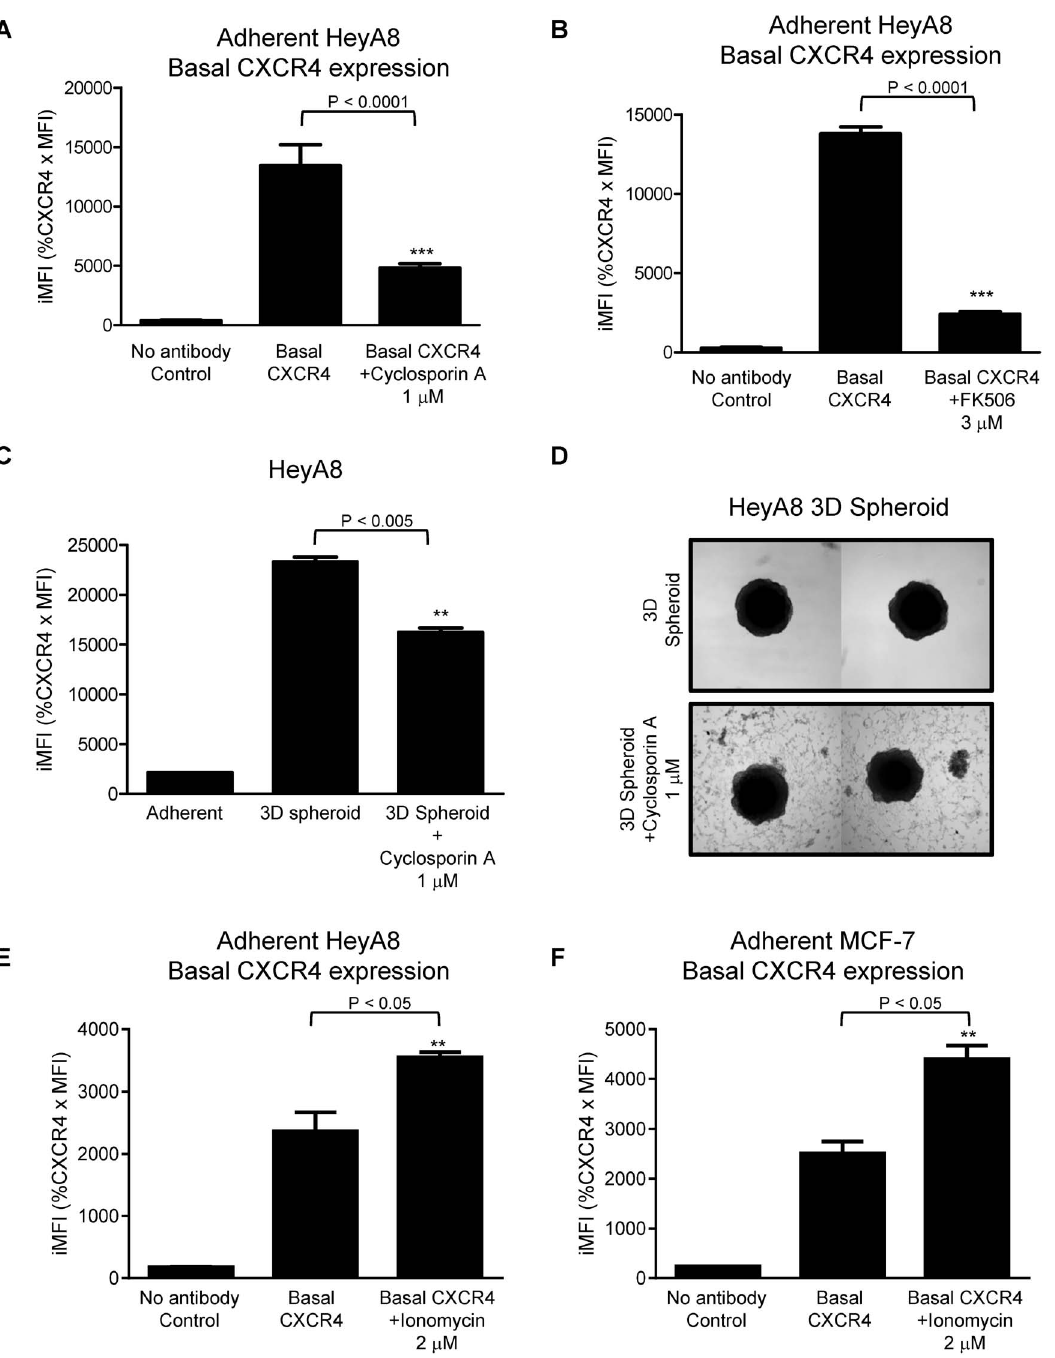
Fig. 6. NFAT3 regulates CXCR4 expression. HeyA8 cells were cultured as a monolayer (adherent) and as 3D spheroids as described in materials and methods. HeyA8 adherent cells were treated with calcineurin-NFAT inhibitor cyclosporin A (1 m M) andFK506 (3 m M) for 72 hours. ( A ) Flow cytometry analysis of HeyA8 adherent cells showed basal CXCR4 surface protein expression was attenuated with the treatment of cyclosporin A as compared to no treatment group (Basal CXCR4). (***, P , 0.0001 vs. CXCR4, 1-way ANOVA). ( B ) HeyA8 adherent cells treated with FK506 showed basal CXCR4 surface expression decreasing similar to cyclosporine A treated cells. (***, P , 0.0001 vs. CXCR4, 1-way ANOVA). ( C ) HeyA8 3D spheroids were treated with Cyclosporin A (1 m M) for 7 days. Flow cytometry showed decreasing levels of surface CXCR4 protein expression treated with cyclosporin A. (**, P , 0.05 vs. 3D spheroid, 1-way ANOVA). ( D ) Picture of HeyA8 3D spheroids from Fig. 6C. Cyclosporin A treated 3D spheroids compared to 3D spheroid control showed